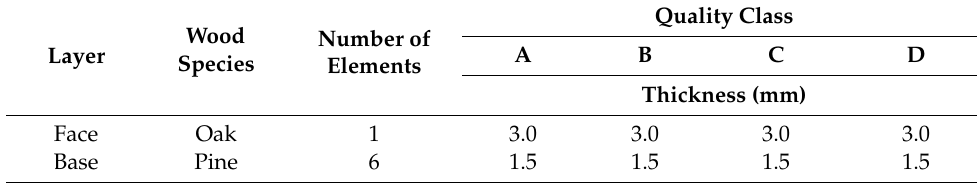
Table 1. Layout of individual layers.